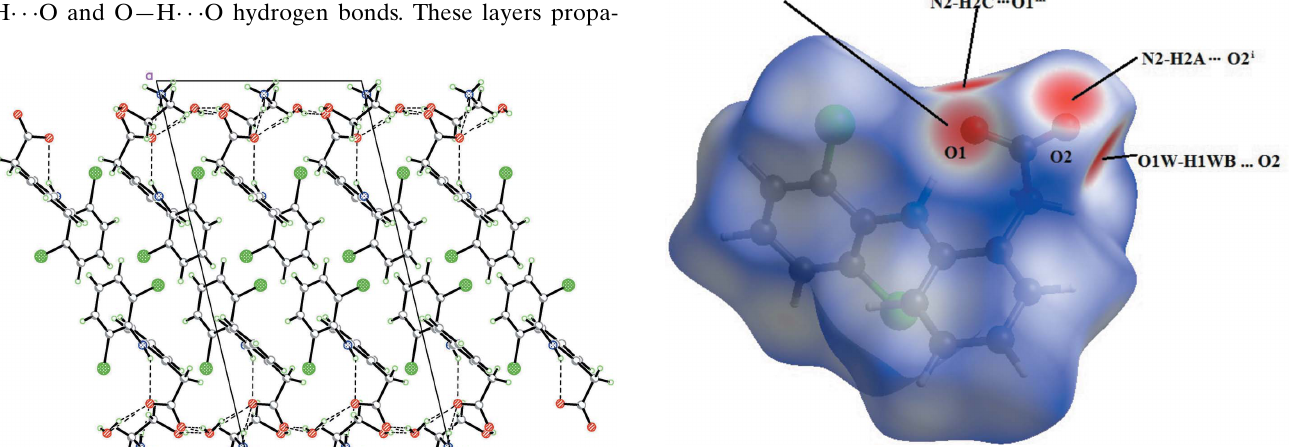
Figure 3 The Hirshfeld surface analysis indicates that the most important contributions to the crystal packing are from H (cid:2)(cid:2)(cid:2) H (31.0%), H (cid:2)(cid:2)(cid:2) C/ C (cid:2)(cid:2)(cid:2) H (26.3%) and H (cid:2)(cid:2)(cid:2) Cl/Cl (cid:2)(cid:2)(cid:2) H (25%) interactions.